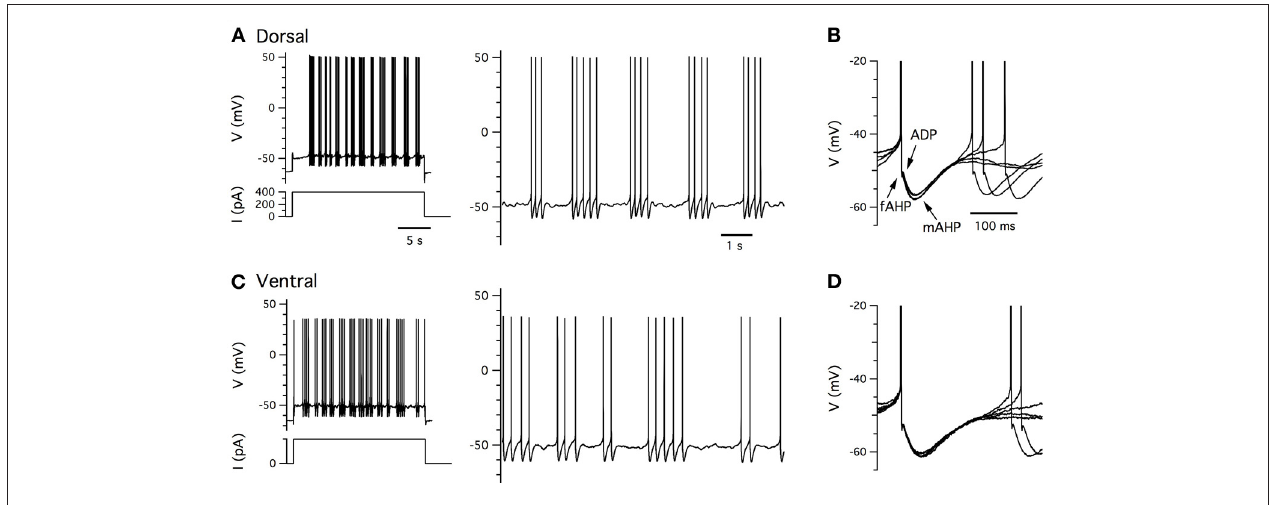
FIGURE 5 | Clustered firing patterns. (A,C) Examples of perforated patch-clamp recordings of supra-threshold membrane potential responses (upper left) to positive current steps (lower left) from dorsal (A) and ventral (C) stellate cells. Action potentials on an